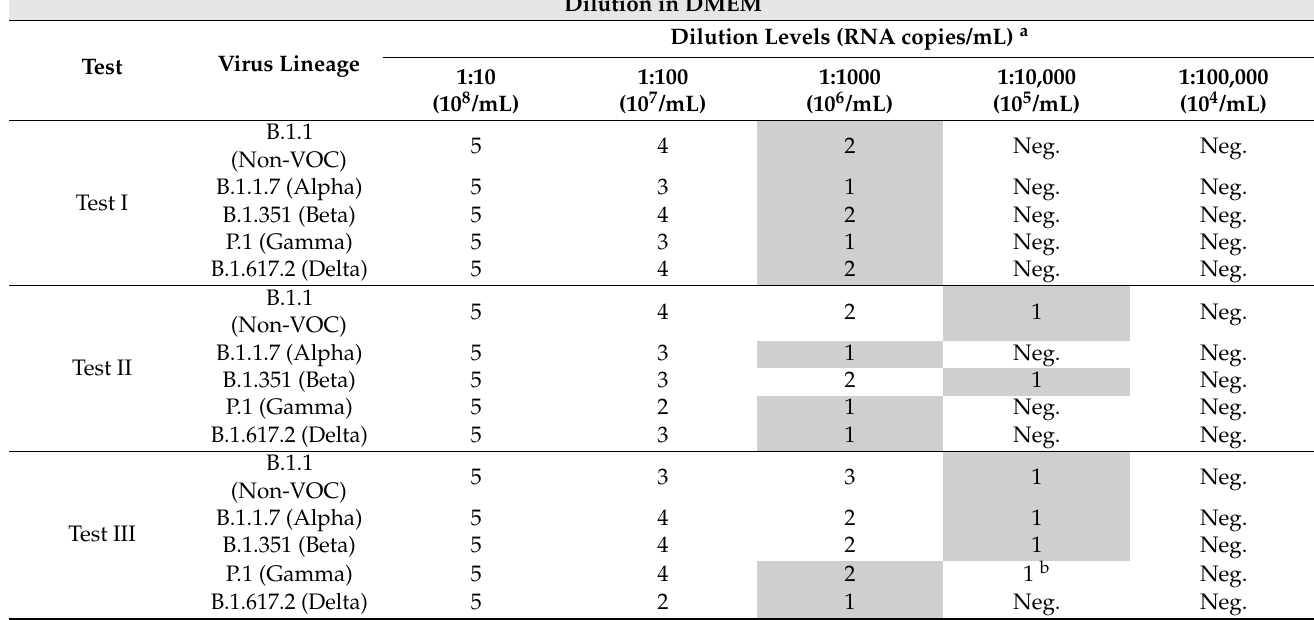
Table 2. Limits of detection with cultured strains from non-VOC B.1.1 and VOCs B.1.1.7 (Alpha), B.1.351 (Beta), P.1 (Gamma), and B.1.617.2 (Delta) based on virus dilution series in DMEM and